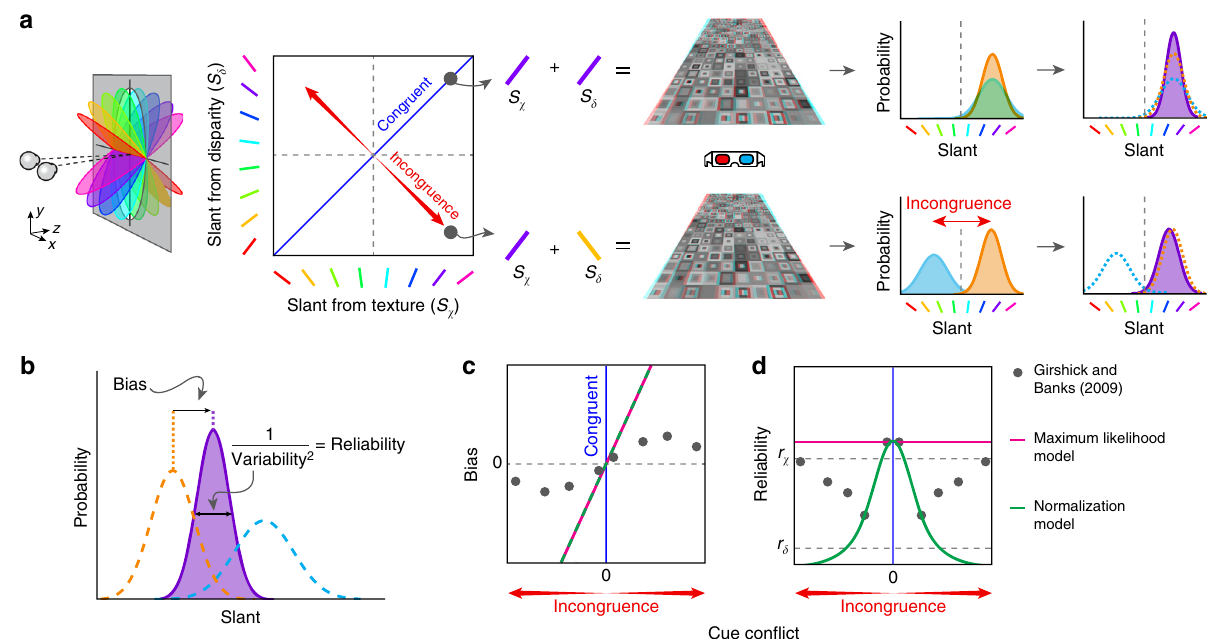
Fig. 1 Illustrations of cue incongruence and the performance of previous models relative to psychophysical data. a The space of possible slants depicted by texture and disparity cues. To illustrate cue integration we provide a cartoon of the slant of 3D surfaces de fi ned by congruent (top) and incongruent (bottom) cues for viewing through red – cyan anaglyph glasses. Sensory estimates are modelled as Gaussian distributions. For congruent cues (top row), fusion (purple curve) produces a more reliable estimate (i.e., lower variance) than for either component (orange, blue curves). For incongruent cues (bottom row), accuracy is maintained by down-weighting the in fl uence of the less reliable cue. b Illustration of the bias (offset in the mean) and reliability (inverse of the variance) parameters used to describe the data. c , d Behavioural measures extracted from Girshick and Banks 7 showing c perceived slant (quanti fi ed by bias away from the more reliable cue) and d reliability as a function of cue con fl ict. Pink and green curves indicate the predictions made by the maximum likelihood model and the Normalization model 25 ,